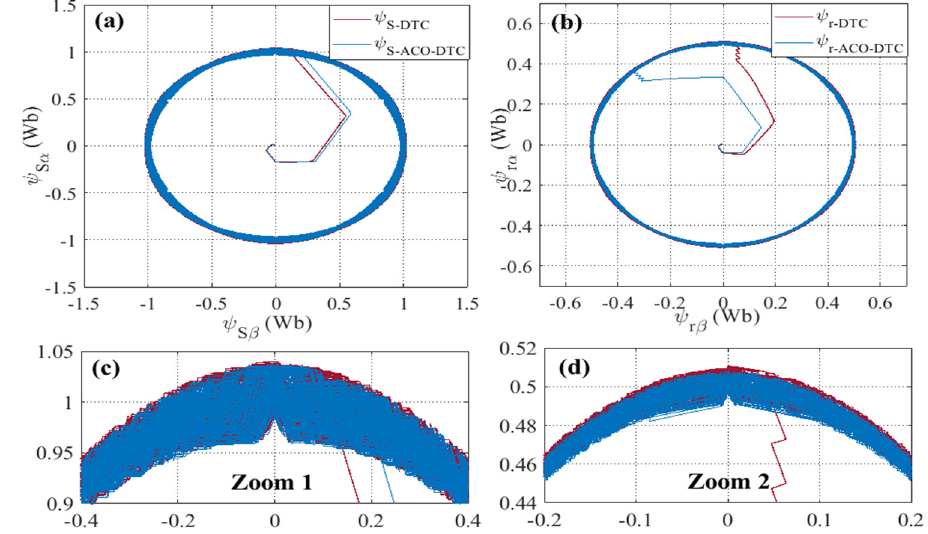
Figure 17. Stator ( a , c ) and rotor ( b , d ) fluxes responses of DTC and intelligent ACO-DTC.